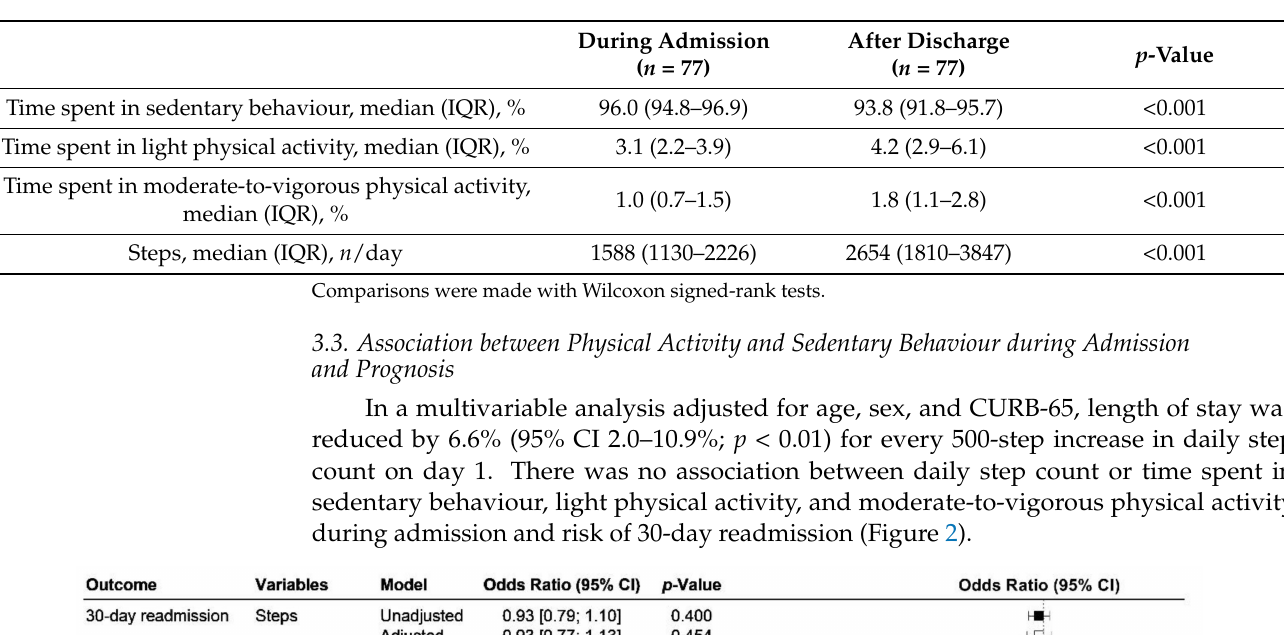
Table 2. Physical activity and sedentary behaviour during admission and after discharge among 77 patients admitted with community-acquired pneumonia.